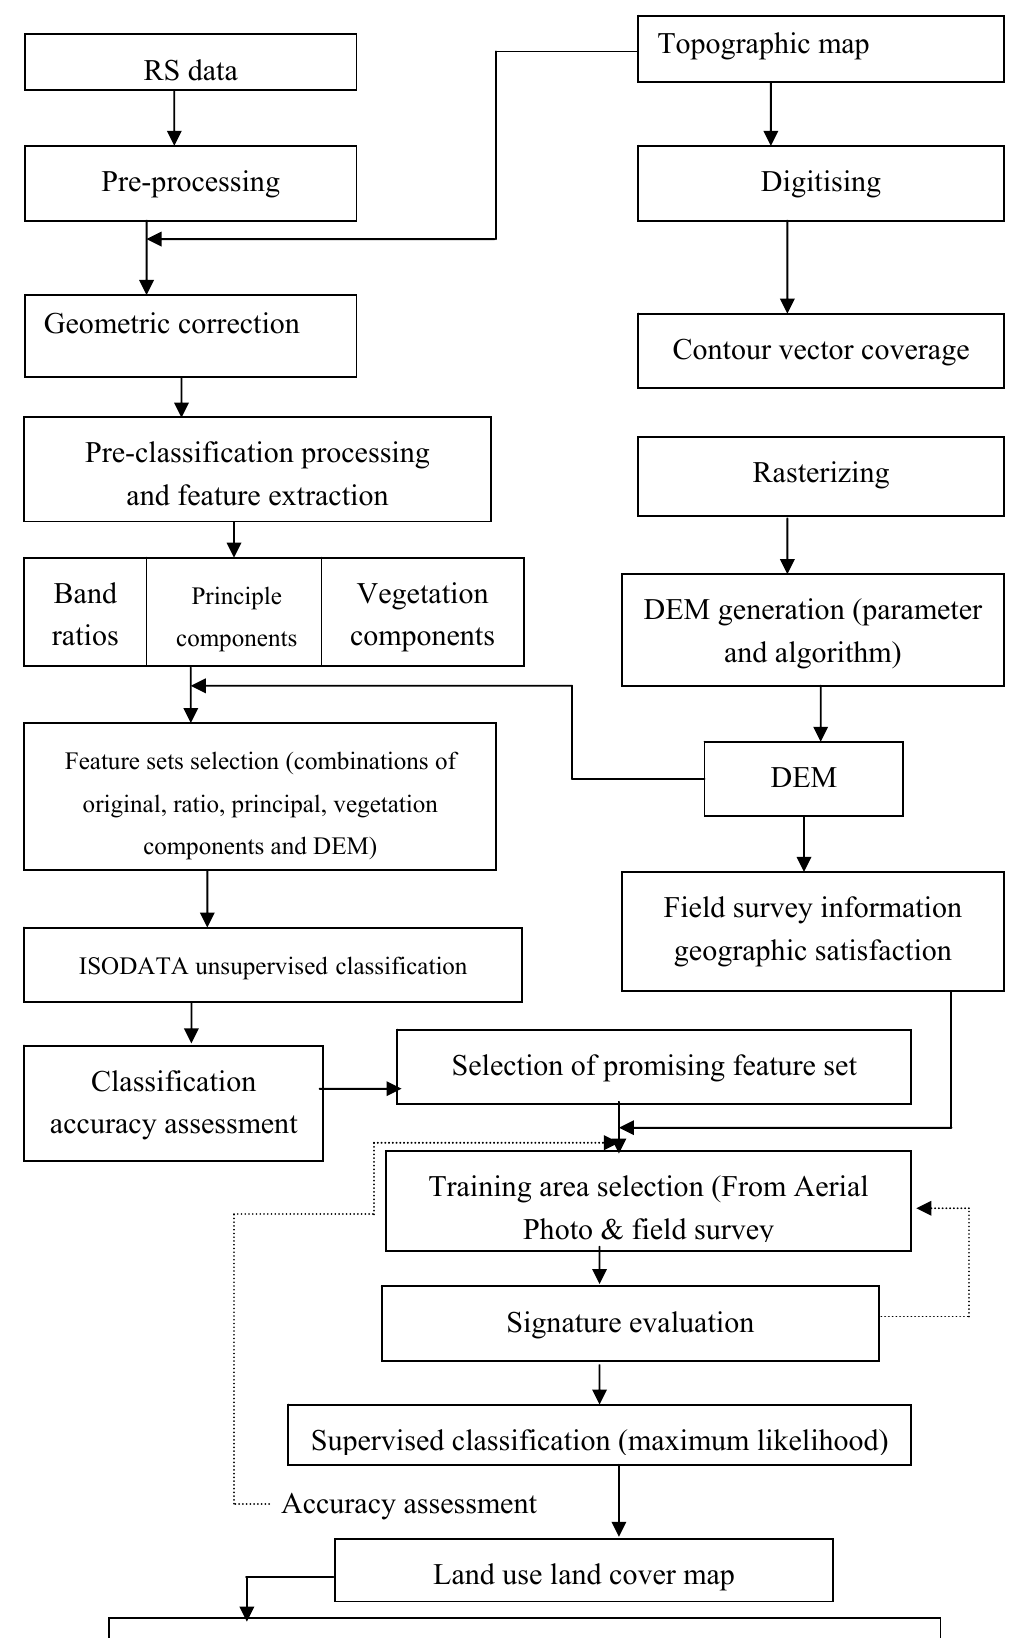
Figure 3. Steps of digital image processing to produce land use land cover